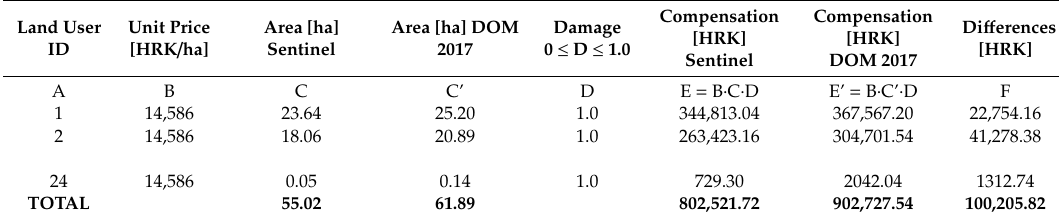
Table 3. Compensation by land users according to the rulebook on the methodology for determining the market price for the sale of agricultural land owned